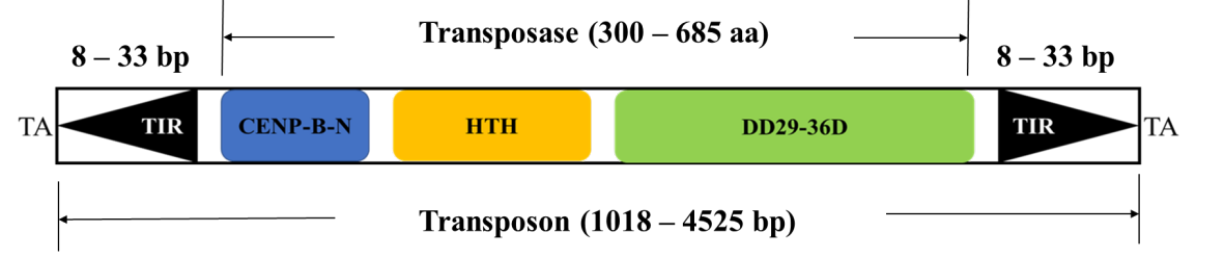
Figure 4. Tigger ’ s structural organization. TIRs are shown by black arrows, CENP-B-N motifs by blue rectangles, HTH sequences by yellow rectangles, catalytic domains (D: aspartic acid) by green rectangles, and TA is the target site of duplication.